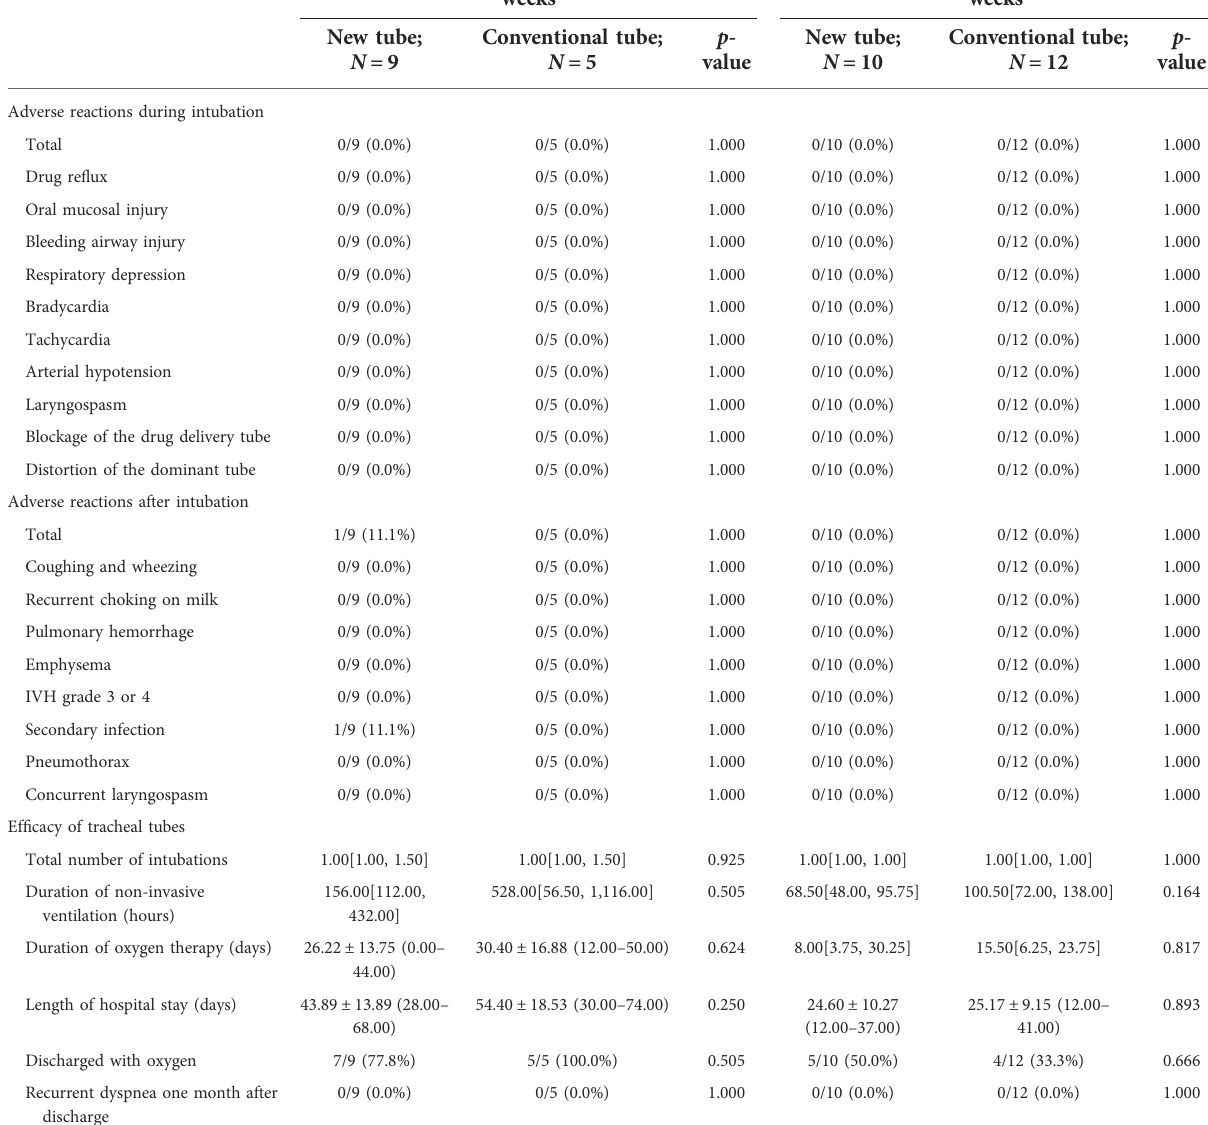
TABLE 11 Clinical outcomes of premature newborns receiving the inSurE technique with gestational age ≤ 32 weeks and >32